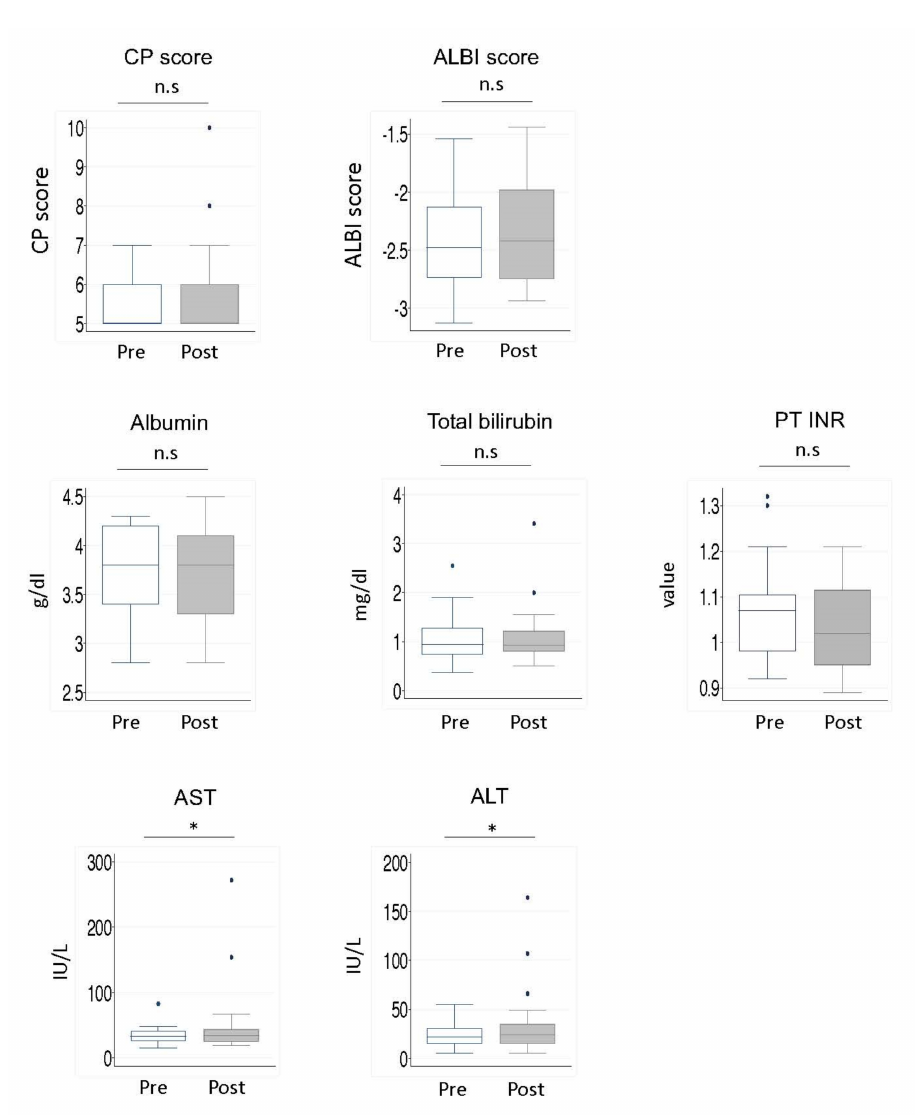
Figure 5. Changes in liver function reserve, serum albumin, total bilirubin, prothrombin-time INR, AST, and ALT levels after vaccination in patients with both cirrhosis and autoimmune diseases (n = 28). *: p < 0.05, n.s.: not significant. 2.5. Vaccination Effects on Liver Function Tests in Noncirrhotic Patients In noncirrhotic patients, the serum albumin and PT levels improved after vaccination. The transaminase and bilirubin levels did not markedly change (Figure